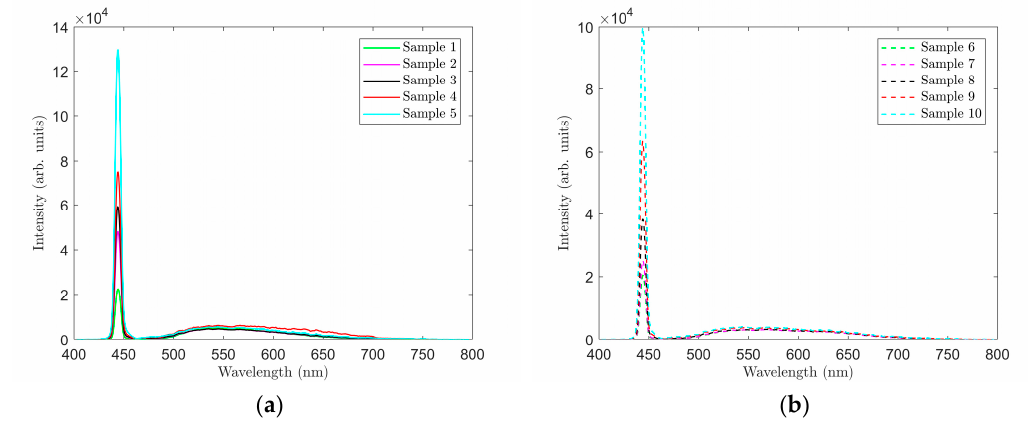
Figure 9. Spectra of samples 1–5 ( a ) and 6–10 ( b ).